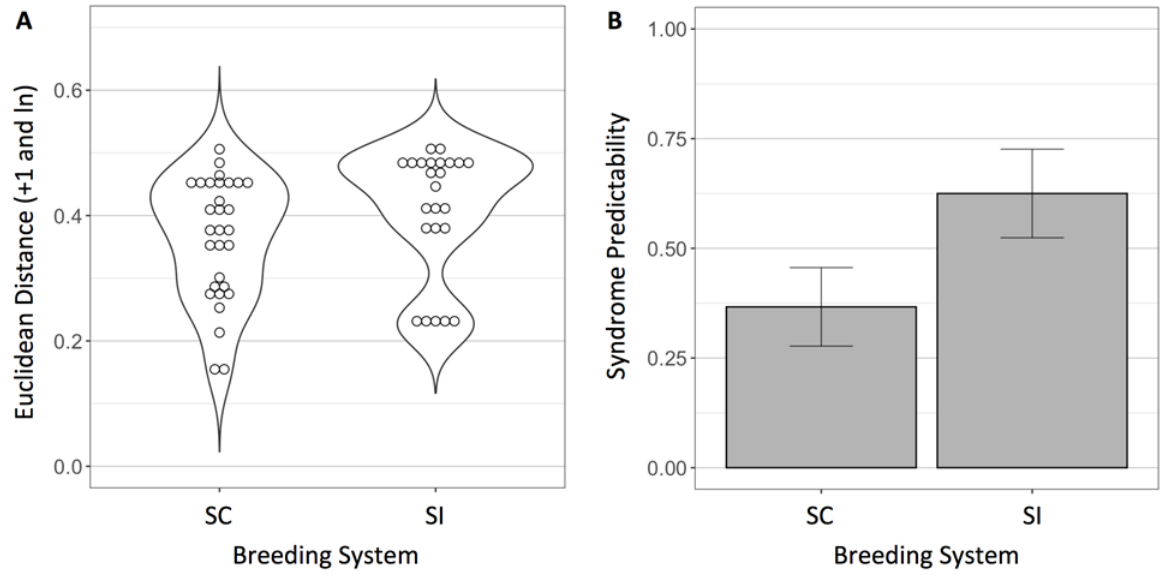
F IGURE 5. Breeding system effects on (A) Euclidean distance (i.e. how close Oenothera floral traits are to a traditional pollination syndrome in morphospace) and (B) whether an Oenothera ’s closest pollination syndrome accurately predicts its primary pollinator (1 = accurate prediction; 0 = inaccurate prediction). In panel A, Euclidean distance is +1 and ln transformed. In panel B, bars are + SE. SC = self-compatible; SI =